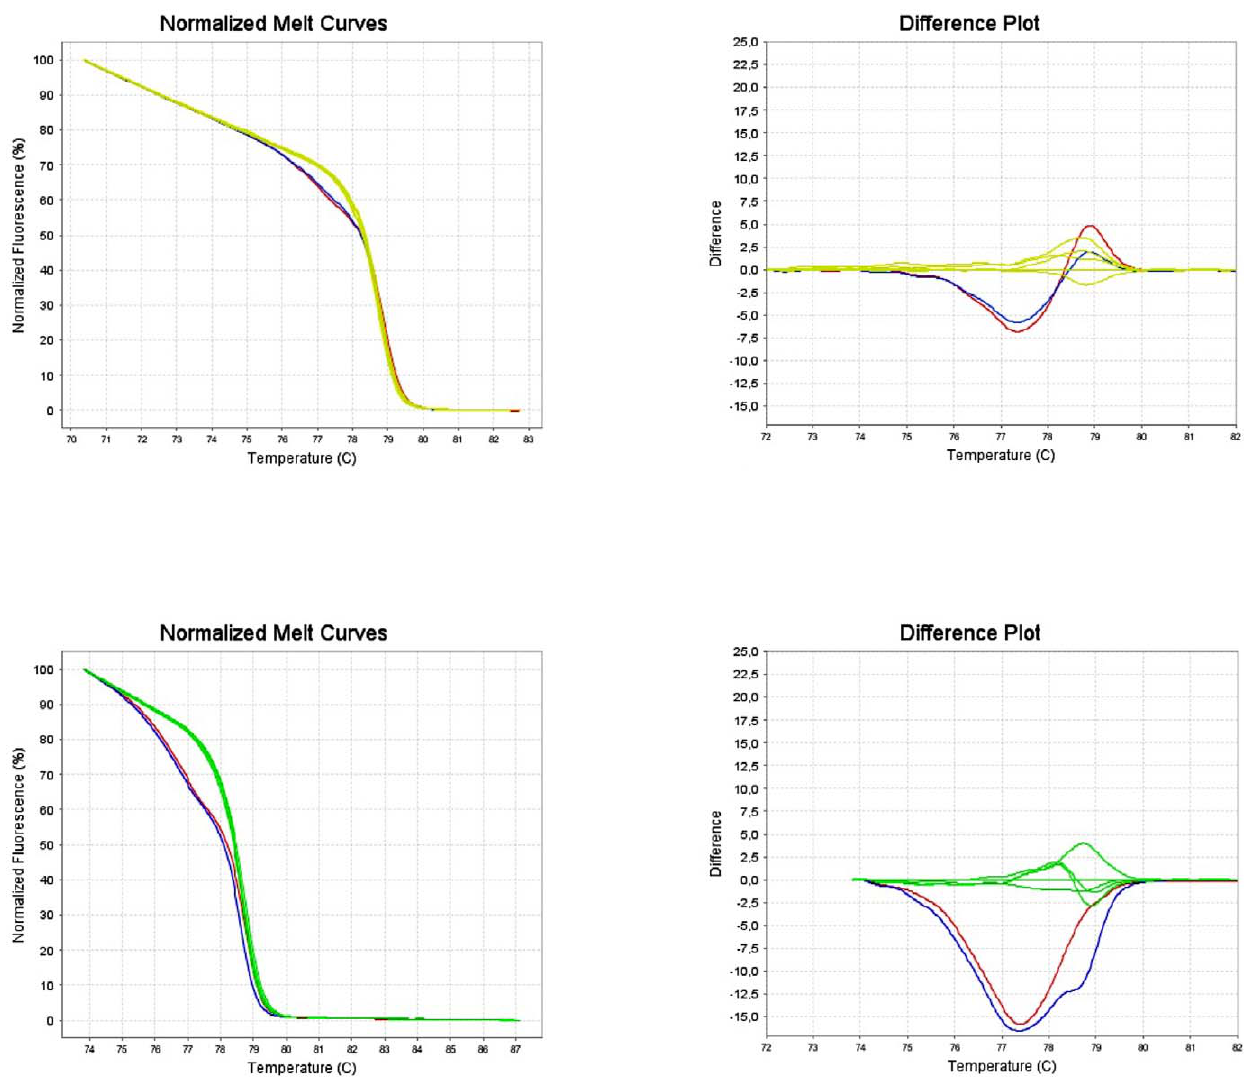
Figure 2. Comparison between total blood and granulocyte DNA. HRM analysis performed in 2 patients on DNA extracted from total blood or purified granulocytes from the same sample. Granulocytes in red, Blood in blue, normal controls in green. Patient 1 in upper panel; Patient 2 in lower panel.